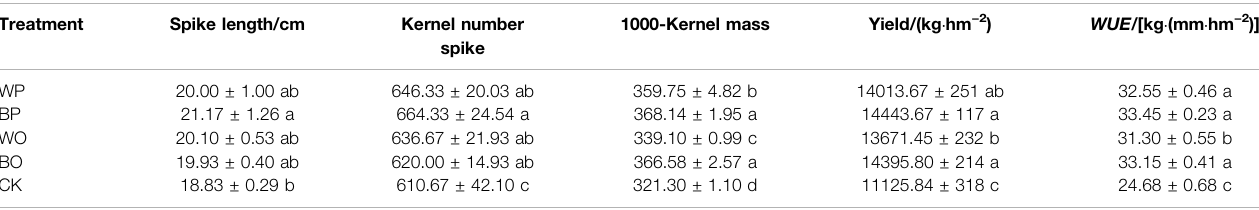
TABLE 2 | Grain yield and yield components of maize and water use ef fi ciency under different mulching fi lms.